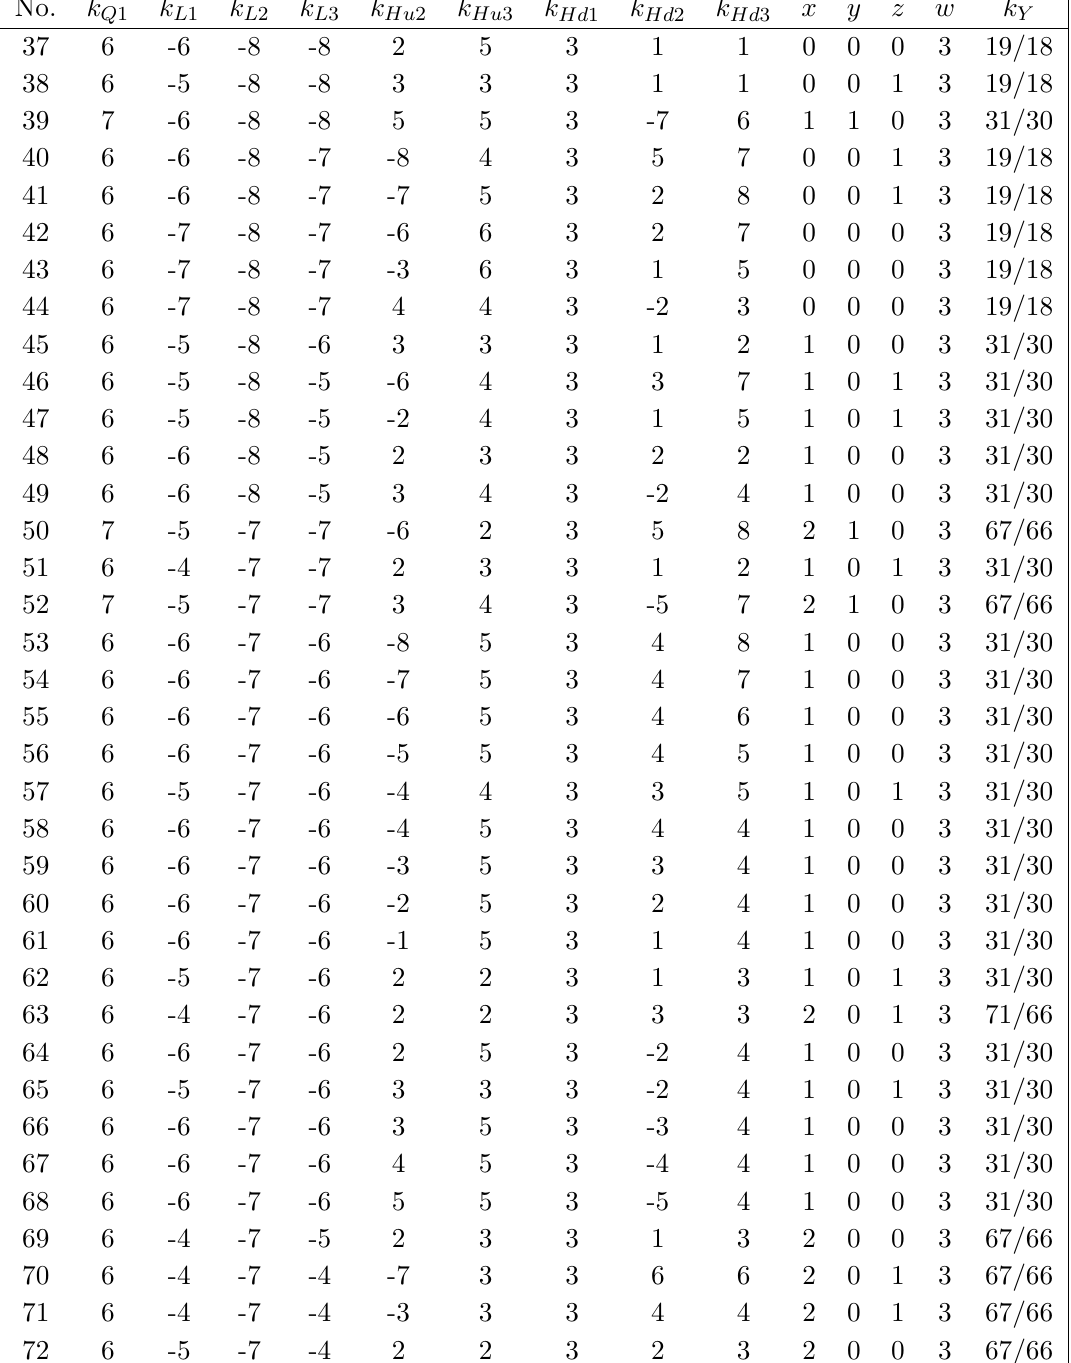
Table 8 . The parameters of the charge assignment ( N h = 3) conti.